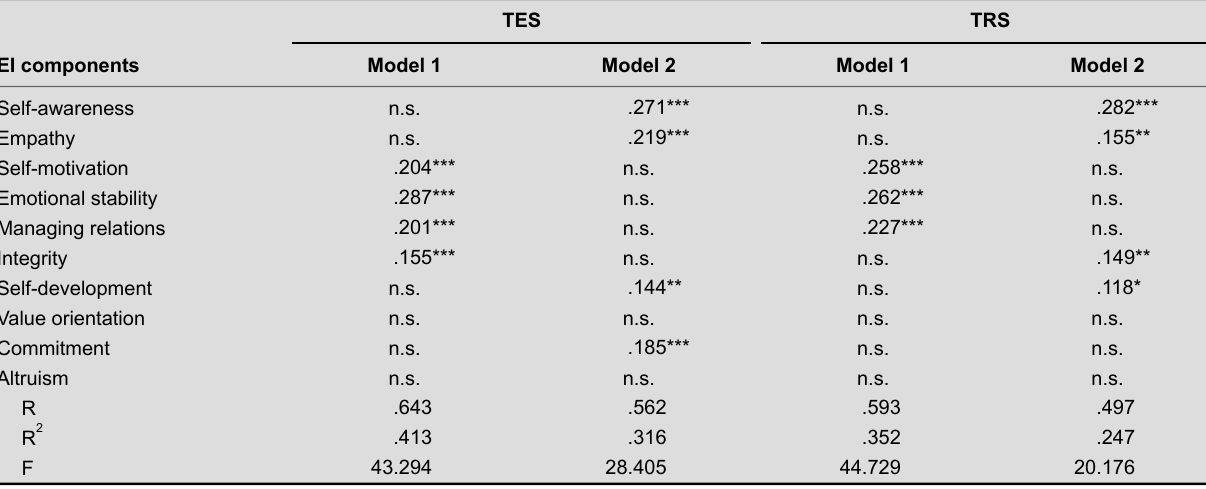
Regression Analysis: Best Fit Models of EI Components as Predictors (β) for TES and